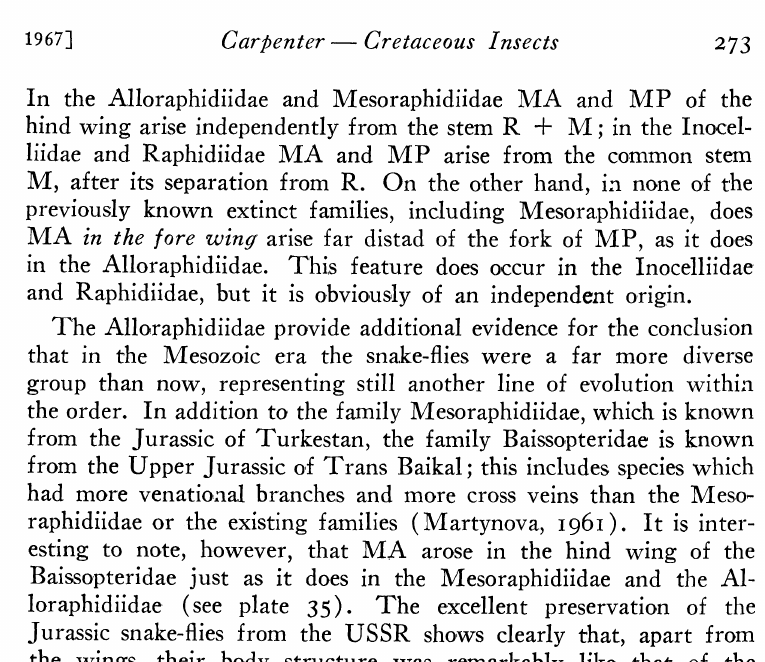
Fig. A. Mesoraphidia pterostitTmalis Martynova, fore wing; Upper Juras- sic, USSR (Kazakstan). Length of wing, 13 mm. After Marty- nova, 1947. Fig. B. Mesorophidia pterostigmalis Martynova, hind wing; Upper Juras- sic, USSR (Kazakstan). Length of wing, 12 mm. After Marry- nova, 1947.